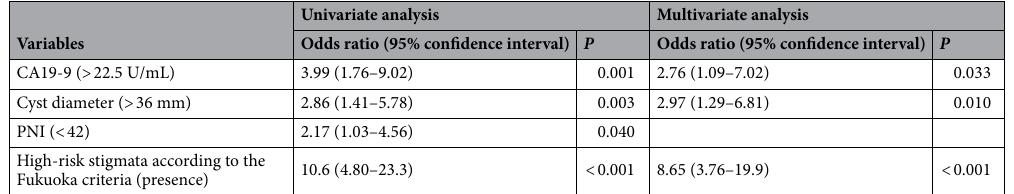
Table 3. Predictors of malignant IPMN among IPMN patients who underwent pancreatectomy. IPMN intraductal papillary mucinous neoplasm, CA carbohydrate antigen, PNI prognostic nutritional index.